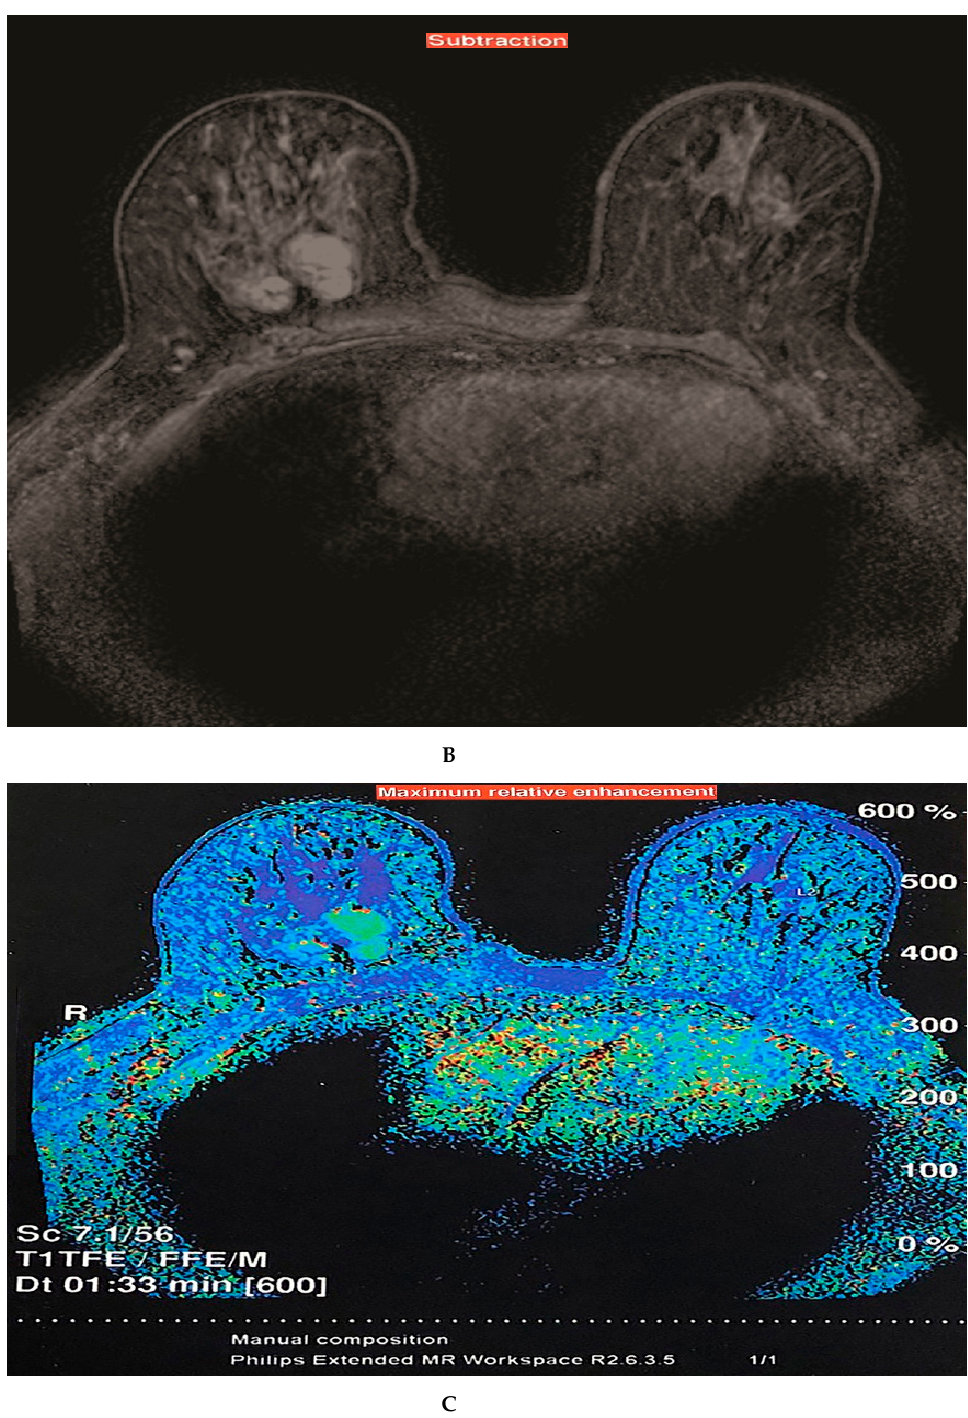
Figure 2. ( A ) Diagnostic MRI (Source). ( B ) Diagnostic MRI (Subtraction). ( C ) Diagnostic MRI (Maximum relative enhancement).